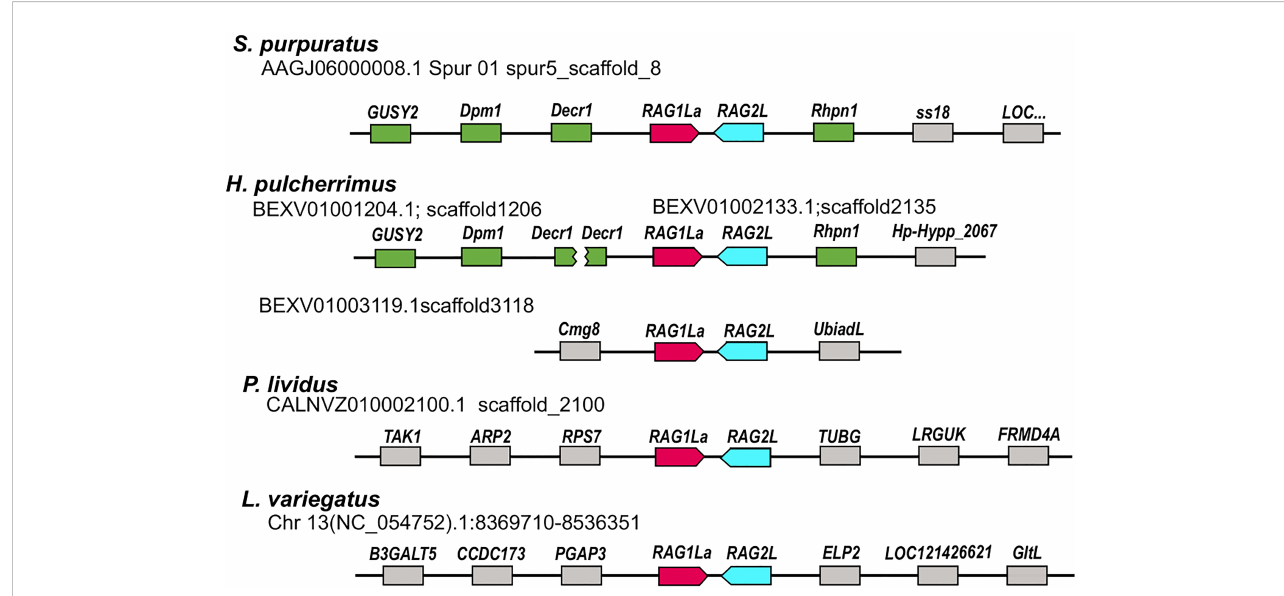
FIGURE 2 Relative genomic locations of type I RAGL genes in sea urchin genomes. The relative genomic location of RAG1/2 genomic pairs in S. purpuratus , P. lividus, H. pulcherrimus and L. variegatus is presented. Matching neighboring genes are marked in green. The SpRAG1/2L and HpRAG1/2L loci are similarly neighboring rhodophilin-1 ( Rhpn1 ) gene upstream to the RAG2L sequence. On the other side, upstream to the RAGL1 sequence, the RAG loci are adjacent to 2,4-Dienoyl-CoA Reductase-1 ( DECR1 ) gene. The H. pulcherrimus genome scaffold BEXV01002133.1 is ending in the middle of DECR1 gene but another scaffold - BEXV01001204.1 includes the rest of the DECR1 gene sequence as well as two other genes with similarity to Dolichol- phosphate mannosyltransferase subunit 1 ( DPM1 ) and Retinal Guanylate Cyclase 1-like ( GUSY1 ) similarly to the corresponding neighboring RAG1/2L genes of the S. pupuratus